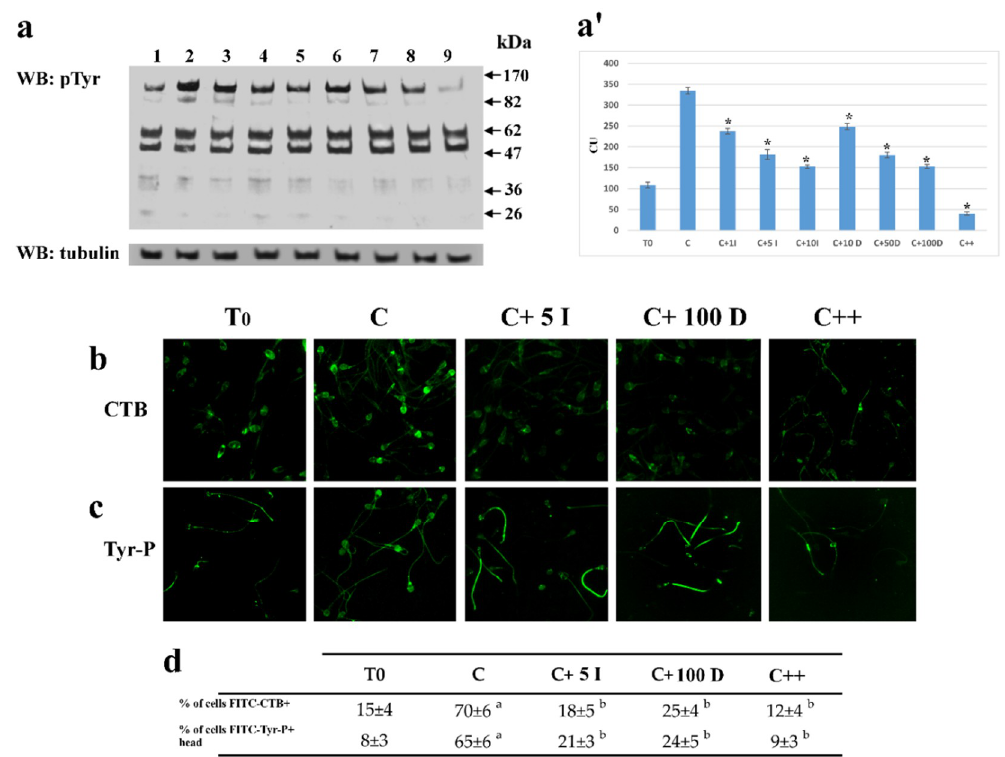
Figure 2. E ff ect of I-172 and DIDS on sperm Tyr-P level and CTB displacement. ( a ): Sperm samples (1 × 10 6 cells) before, T0 (lane 1), and after 120 min of incubation in the absence (lane 2) or presence of 1 (line 3), 5 (lane 4) 10 (lane 5) µ M I-172, or 10 (lane 6), 50 (line 7) or 100 (lane 8) µ M DIDS, or both (lane 9) were analyzed by Western blotting with anti-P-Tyr antibodies, the response to which was normalized against tubulin expression; all as described in Methods); ( a’ ) bands corresponding to the phosphorylated proteins were densitometrically estimated, normalized to tubulin, and statistically analyzed. The figure is representative of 6 separate experiments. Data show the means ± SD of relative units (RU). Comparison to C values: * p < 0.001, ( b ). FITC-labeled CTB staining (panel b ), highlighting the shifting of ganglioside GM1 embedded in membrane microdomains, and FITC-labeled P-Tyr staining (panel c) on sperm cells were also analyzed by immunofluorescence in T0, C, C + 5 µ M I-172 (C + 5I), C + 100 µ M DIDS (C + 100 D), or both (C ++ ), as described in Methods. The figure is representative of 3 separate experiments. ( d ) Number of cells FITC-CTB + and number of cells Tyr-P + in the head are expressed as means ± SD% of the total number of cells analyzed. (a p < 0.0001, b: p < 0.001, comparing each sample against C values).